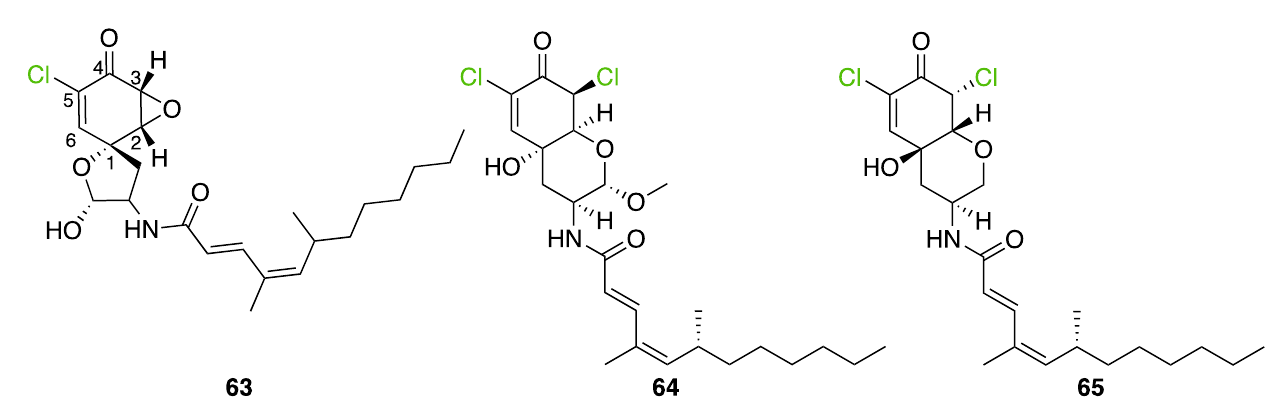
Figure 28. Metabolites present in cluster 4, aranochlor A ( 63 ) from Pseudoarachniotus sp., dankastatin A ( 64 ) and B ( 65 ) from Gymnascella sp.